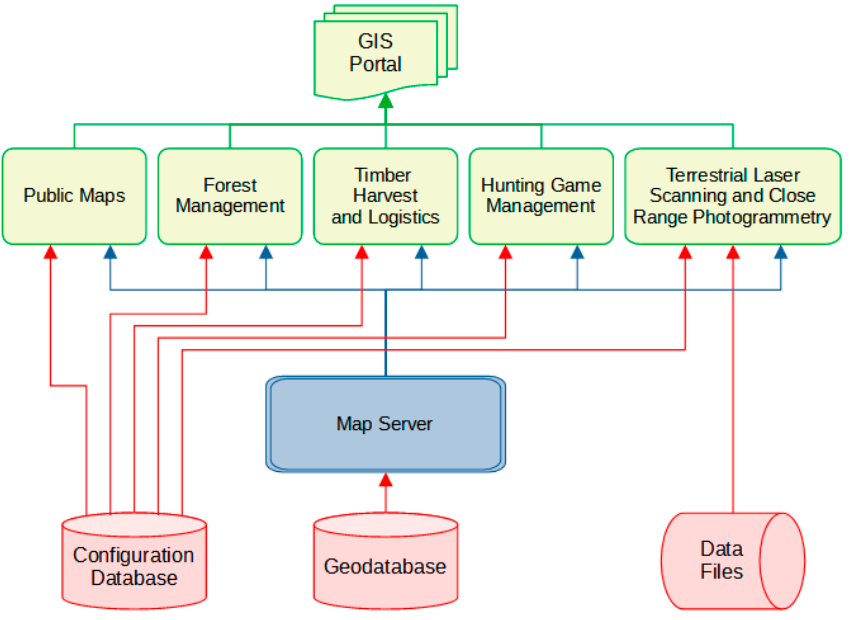
Figure 1. Architecture of the web-based GIS prototype.